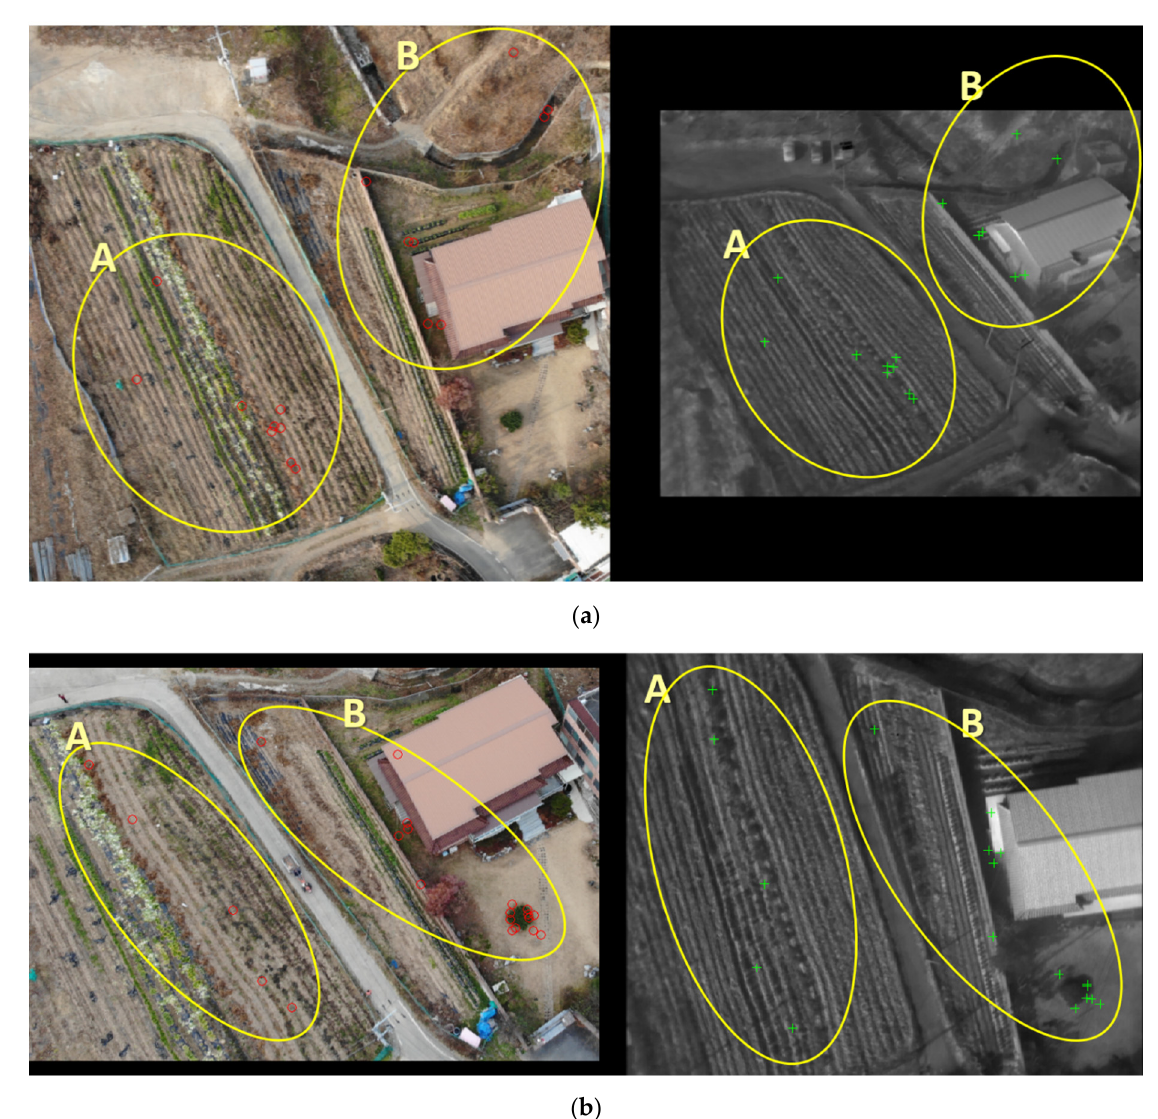
Figure 10. Understanding the characteristics of feature points of the non-building type: ( a ) visible nadir-looking vs. TIR oblique case; ( b ) visible oblique vs. TIR nadir-looking case.